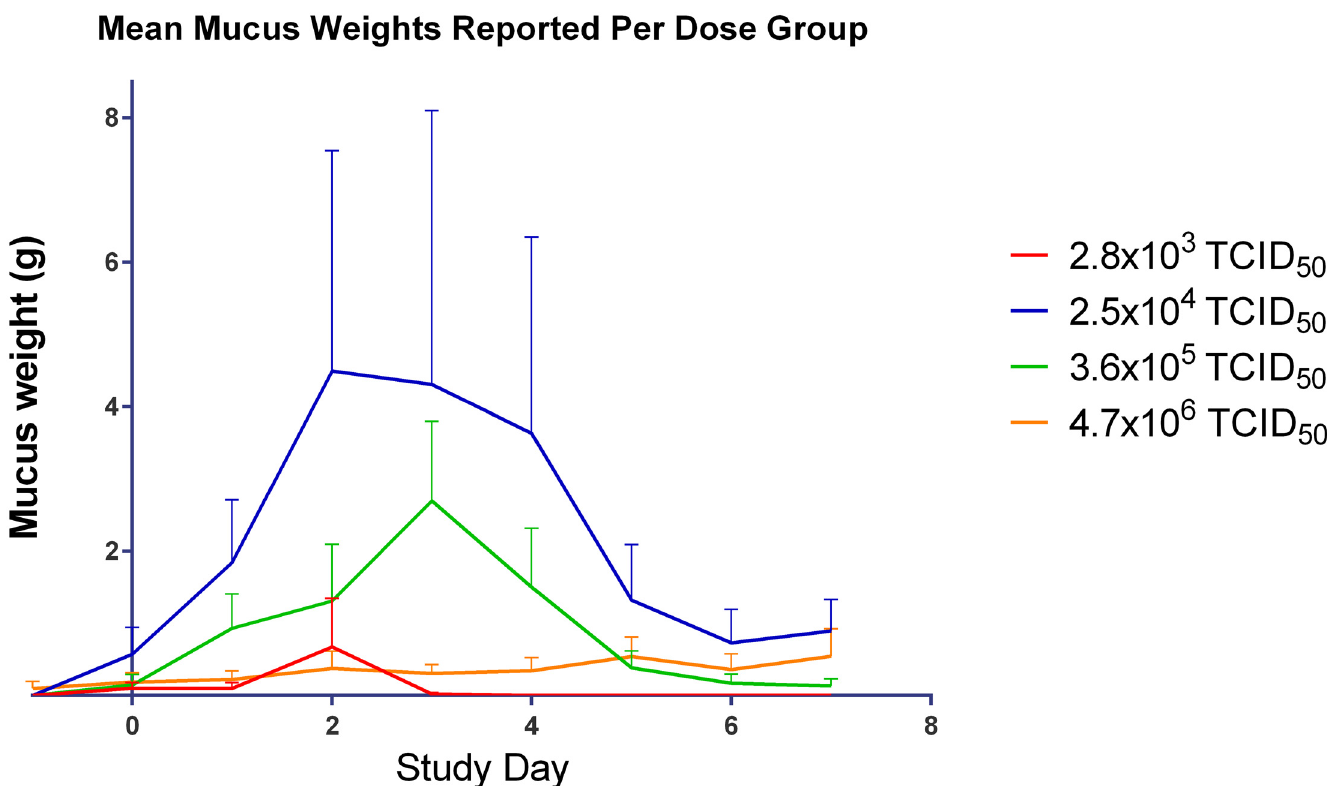
Fig 11. Mean mucus weight by day in all subjects in the Human Viral Challenge